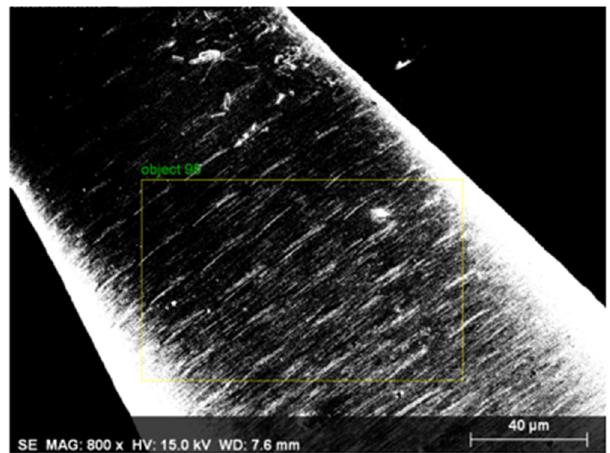
Figure 8. The EDS face sampling area (new electrode). Table 5. The elemental contents of the EDS face sampling area (new electrode).